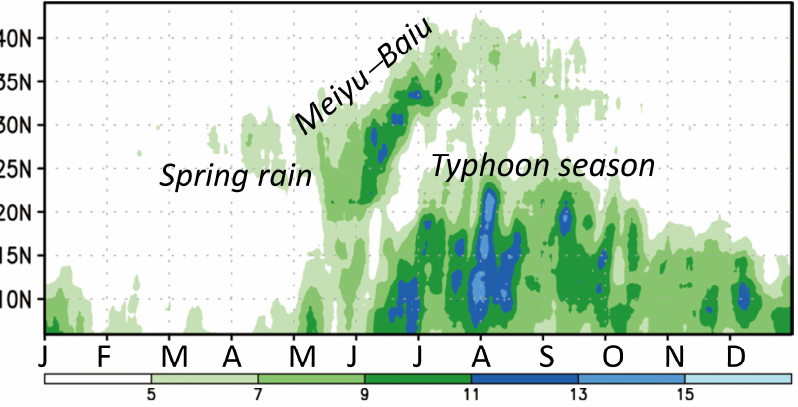
Figure 1. Latitude–time cross section of precipitation (mm day −1 ) averaged over the region 110° E– 140°